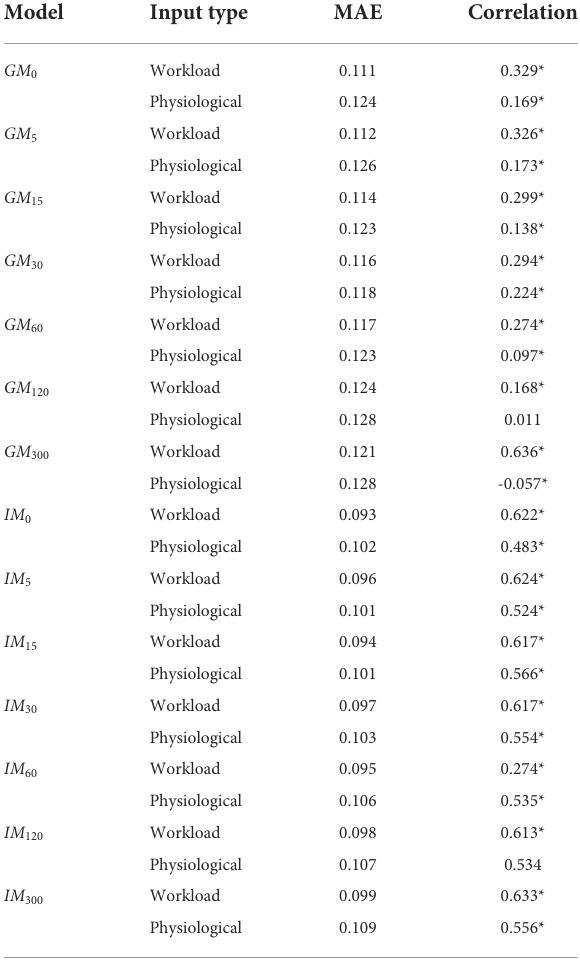
TABLE 5 Accuracy comparison between a workload estimate-based and physiological signal-based performance prediction models.